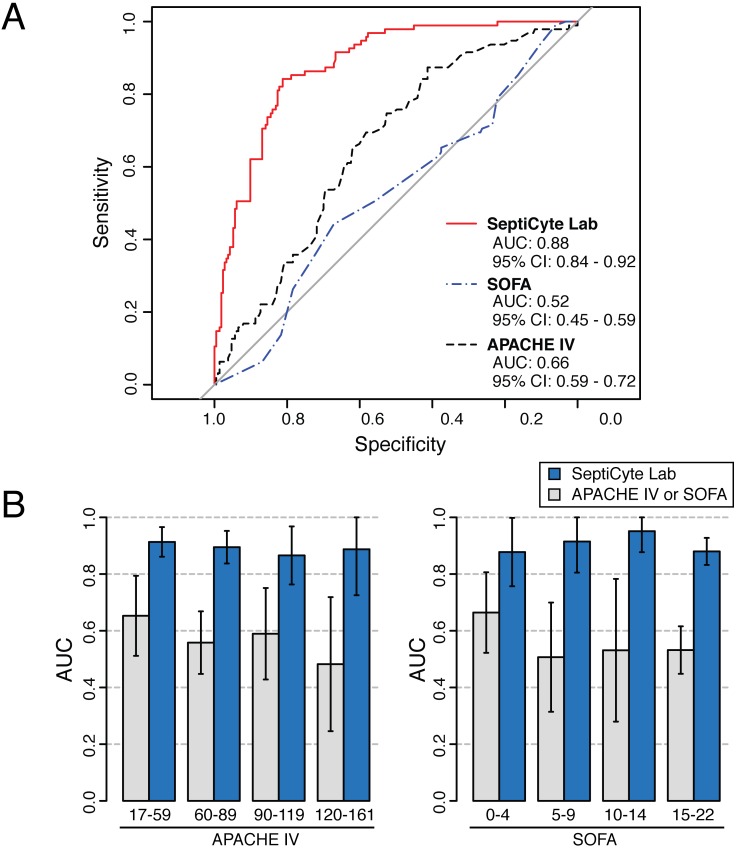
Test for disease severity as a potential confounding variable.Validation cohorts 1–5 (excluding patients with an infection likelihood of possible) were combined, and then stratified on APACHE IV score or SOFA score. (A) ROC curve analysis was performed on the combined dataset. (B) Separate ROC curve analyses were performed over sub-ranges of the APACHE IV score (left) or SOFA score (right). The error bars indicate the 95% CI for the AUC as estimated by resampling. The results for the various strata of APACHE IV and SOFA score indicate that disease severity has a relatively weak influence (AUC = 0.52–0.65) on the discrimination of cases from controls, while SeptiCyte Lab has a much stronger influence (AUC = 0.87–0.91). Additional details of the calculations are given in S5 Data.